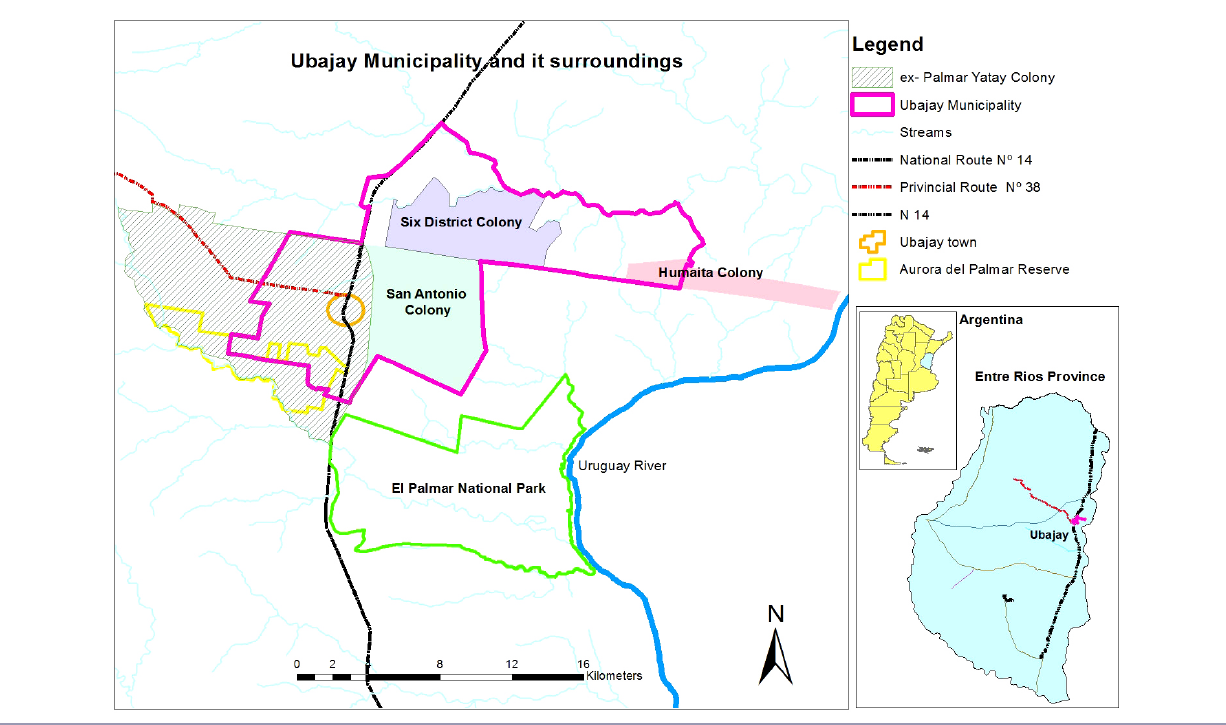
Fig. 1 . Limits of Ubajay Municipality and its